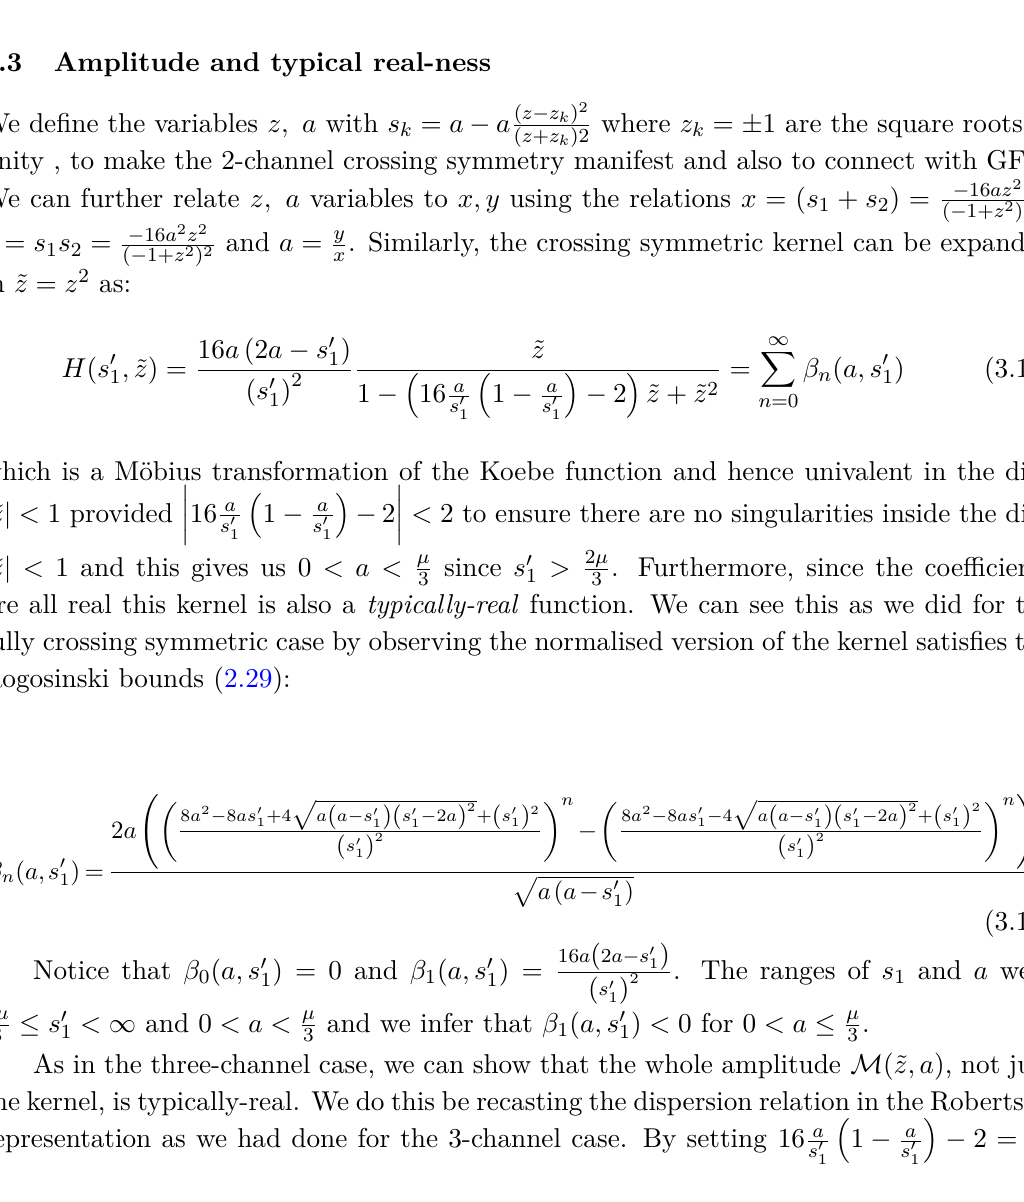
Figure 7. β n /β 1 vs s 1 for n = 2 , 3 , 4 and n = 5 , 6 , 7 , from left to right. The above plots show that the Rogosinksi bounds are respected the 2-channel symmetric amplitude with µ = 4 for the full range of a namely 0 < a < µ 3